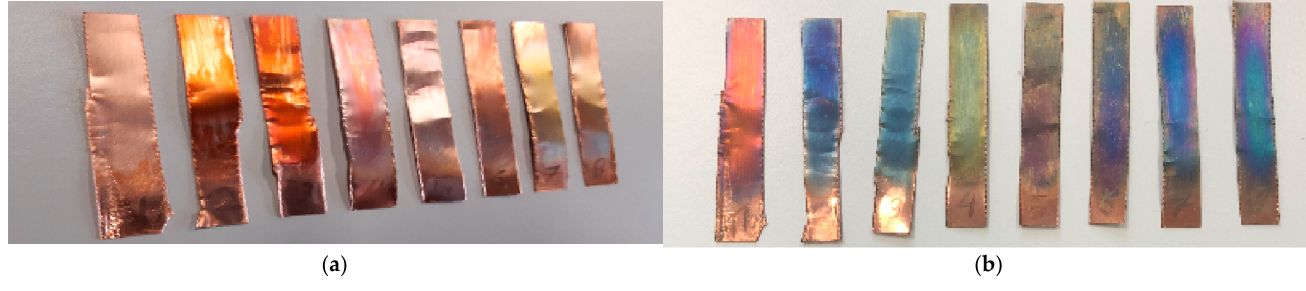
Figure 1. Copper strips directly after oxidative low-pressure plasma treatment ( a ) and after three days ( b ) with pronounced interference effects of the oxidized layers. Picture ( a ) shows the reddish discoloration, which appeared immediately after the ambient air plasma treatment. After one week, different colors appeared, caused by interference effects of copper oxide layers with different thicknesses, as can be seen in photo ( b ).